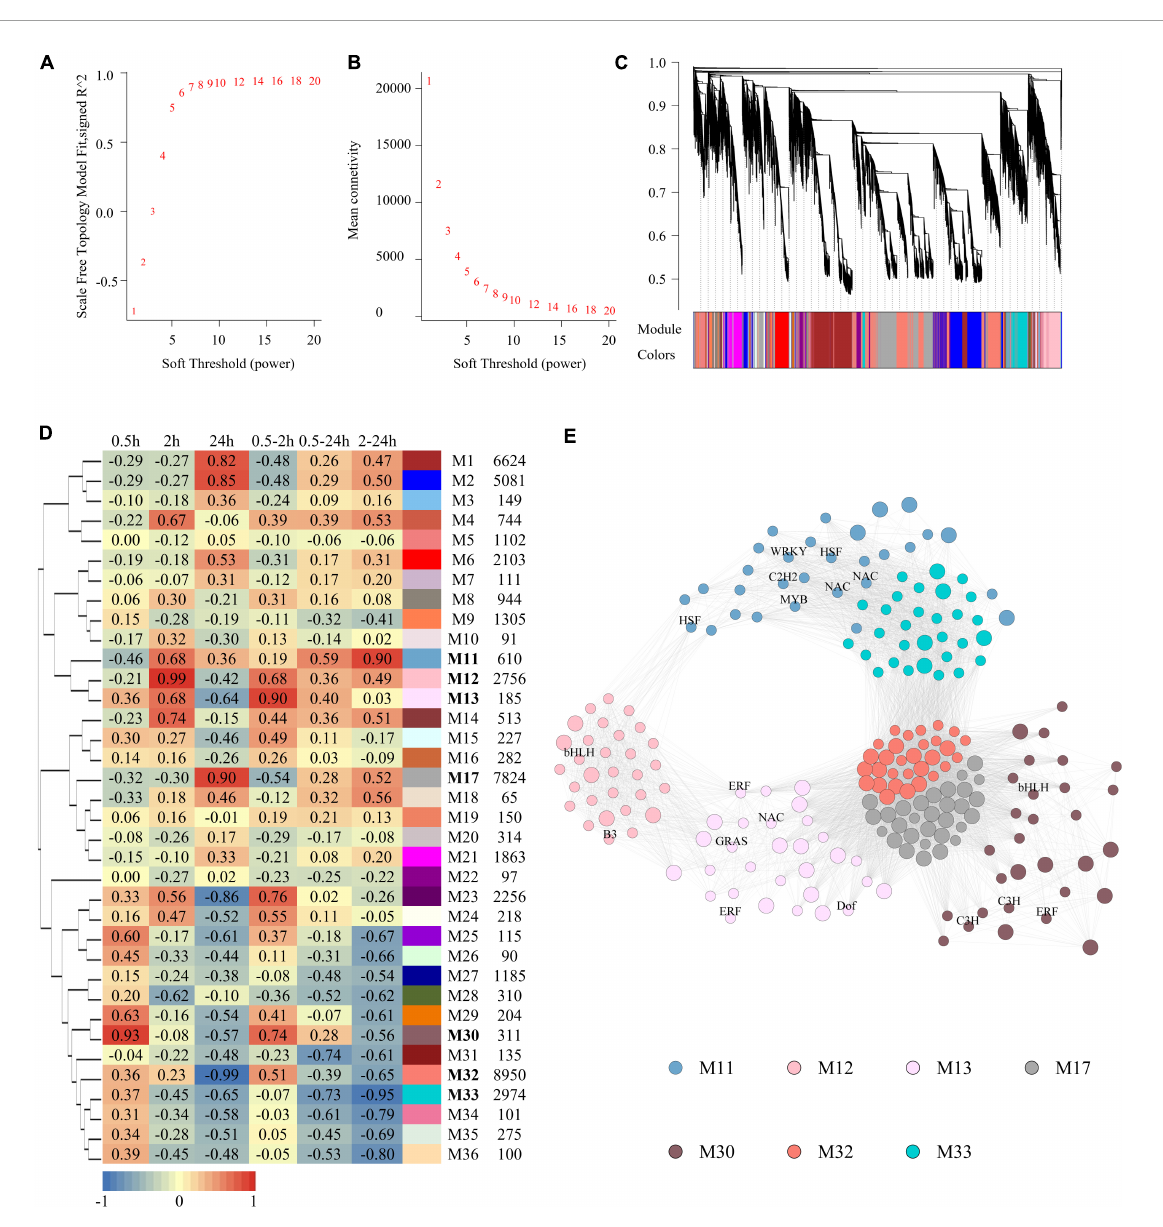
FIGURE3 Construction of gene co-expression network and analysis of salt responsive modules. (A) The scale-free fit index as a function of the soft-thresholding power. (B) The mean connectivity as a function of the soft-thresholding power. (C) Clustering dendrogram of genes, with dissimilarity based on topological overlap. Modules were labeled by colors as indicated by the color band underneath the tree. (D) Heatmap showing the correlation between modules and salt treatment. Each cell contains the corresponding correlation. The table is color-coded by correlation according to the color legend. The columns on the right of heatmap showed module color, module name and module size in turn. (E) Subnetwork of hub genes of salt responsive modules. Modules were represented by different colors as described in Figure 3D . Small circle represented coding RNAs and big circle represent LncRNAs. TFs were